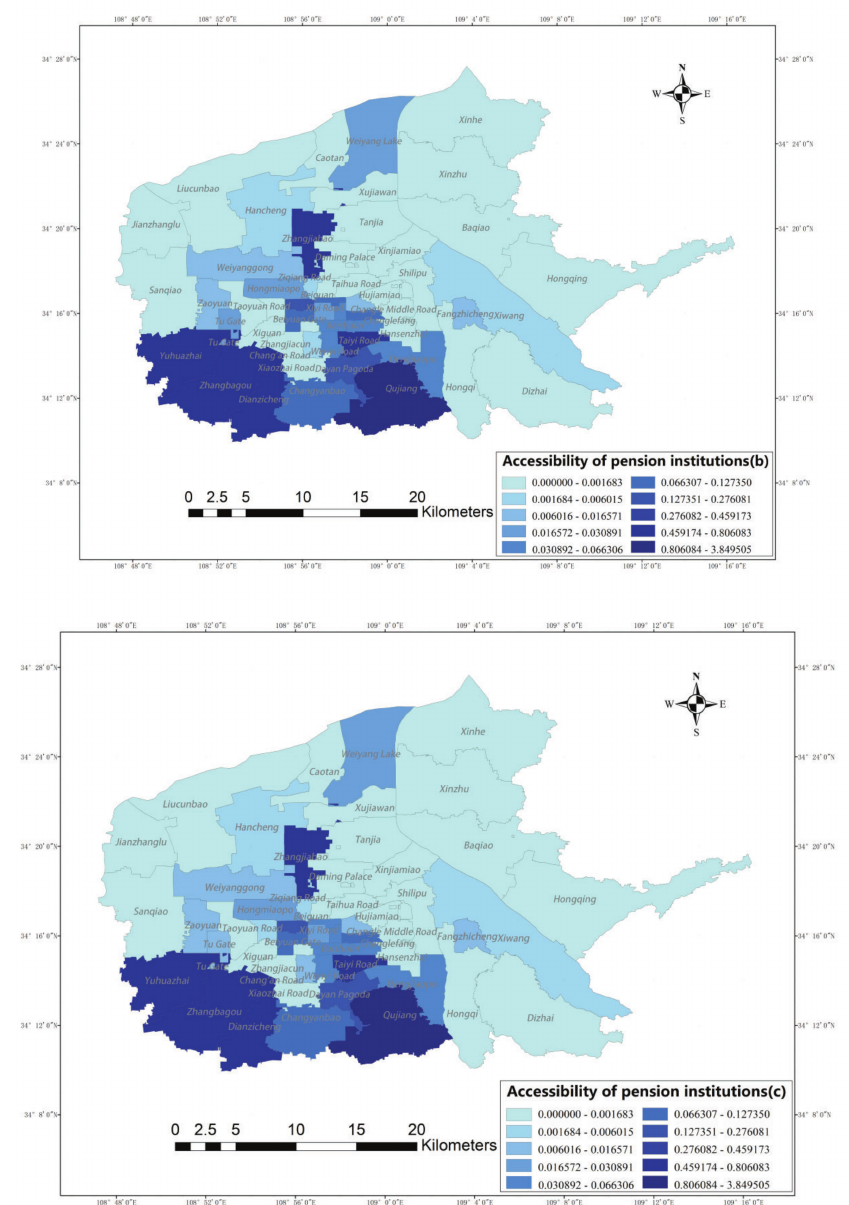
Figure 8. Accessibility of elderly care institutions; ( a ): Before optimization ( b ): Consider the actual path ( c ): Consider the actual path and probability